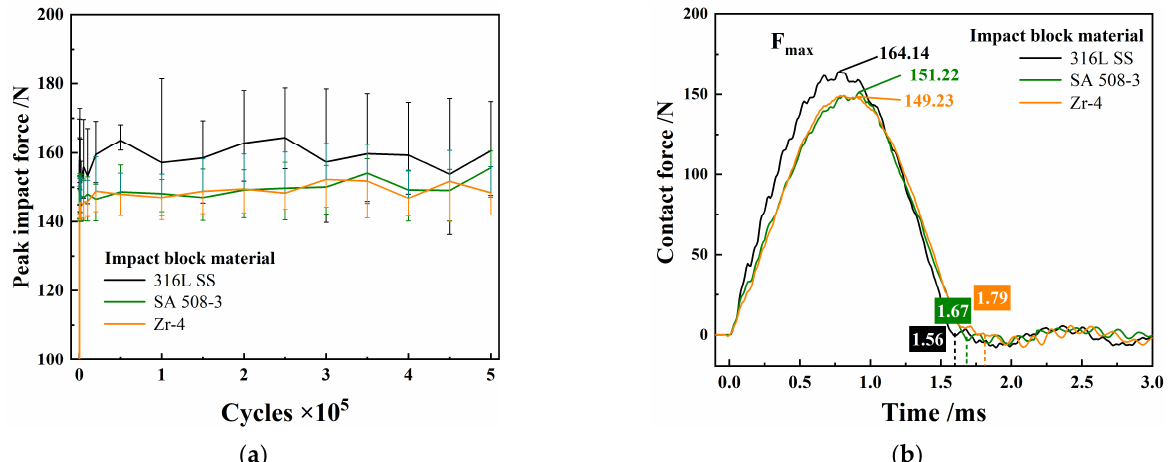
Figure 8. Curve of impact contact force with different impact block materials, N = 5 × 10 5 . ( a ) Impact contact force vs. cycle; ( b ) impact contact force vs. time.